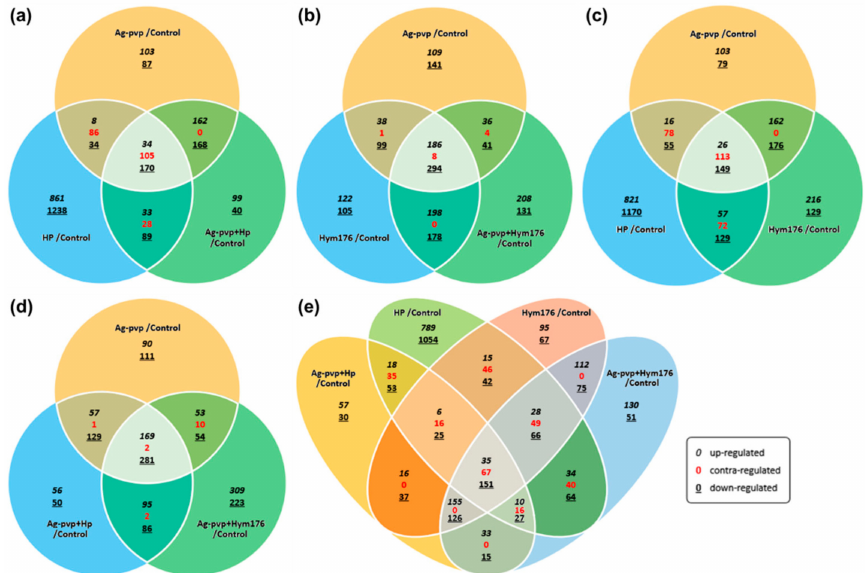
Figure 2. Venn diagrams illustrating the gene expression patterns in each experimental group; contra-regulated means that the e ff ects on gene expression are opposite to each other (Fold change: ≥ 2, ≤ 0.5; Normalized RC (log2): ≥ 10). ( a )Ag-PVP / control vs HP / control vs Ag-PVP + HP / control, ( b )Ag-PVP / control vs Hym176 / control vs Ag-PVP + Hym176 / control, ( c )Ag-PVP / control vs HP / control vs Hym176 / control, ( d )Ag-PVP / control vs Ag-PVP + HP / control vs Ag-PVP + Hym176 / control, ( e )Ag-PVP + HP / control vs HP / control vs Hym176 / control vs Ag-PVP + Hym176 / control. Microarray and DEG analyses were performed on the FC data for genes that a ff ect morphogenesis